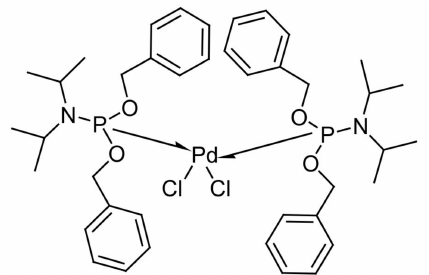
Figure 1. The palladium(II) complex( 1 ).